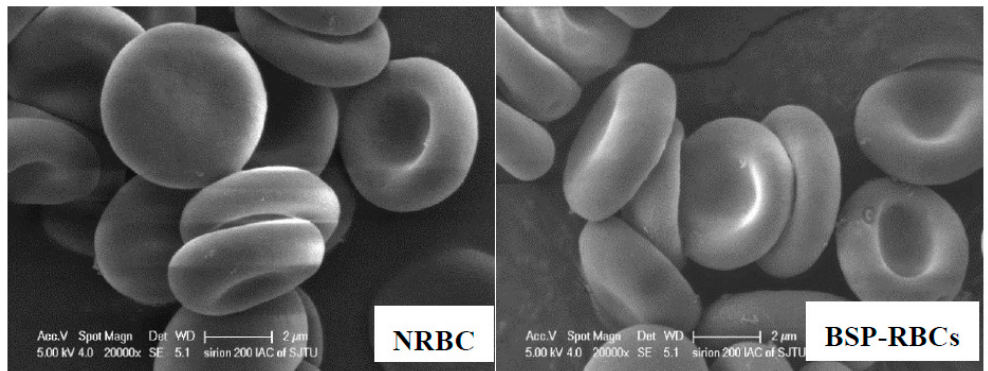
Figure 2. Scanning electron microscopy of NRBCs and BSP-RBCs. NRBCs have a normal biconcave shape, BSP-RBCs have the similar biconcave shape. Magnification is 20,000.